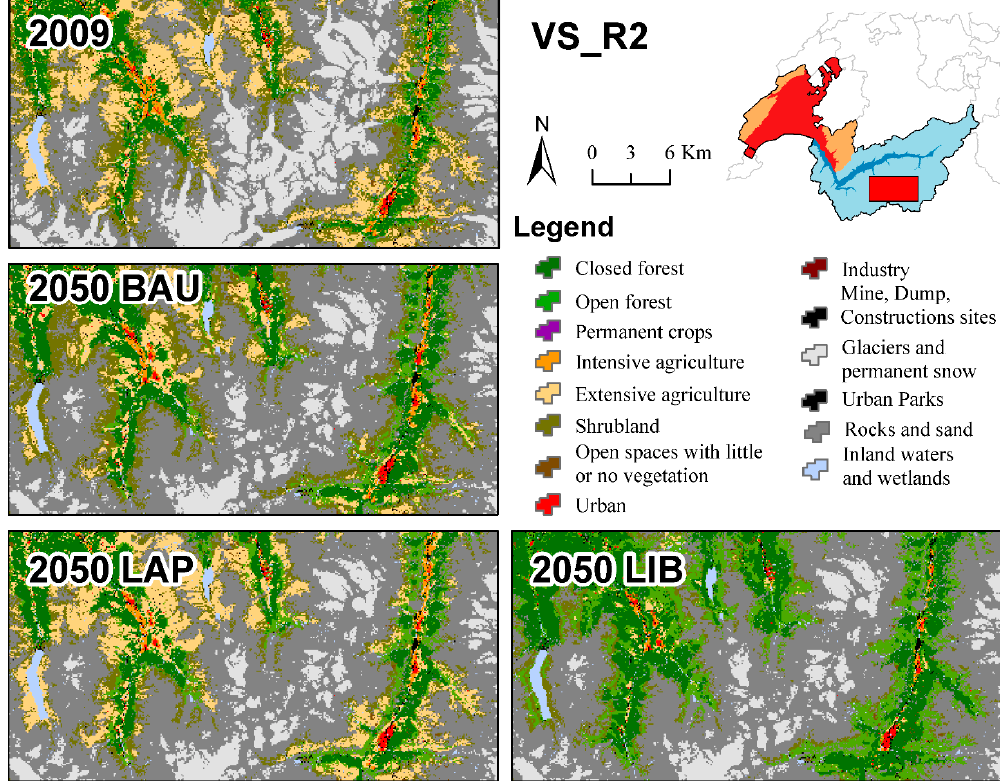
Figure 7. Observed changes for forest, agriculture (intensive and extensive), shrubland and glaciers in Valais above 900 m a.s.l. (VS_R2).